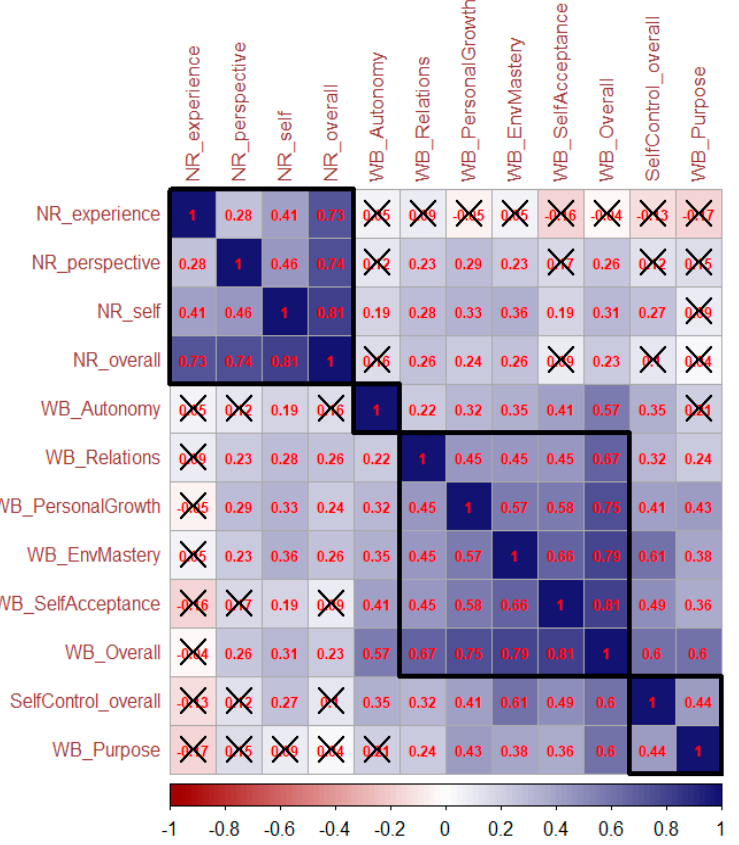
Figure 2. Correlation coefficients for Nature Relatedness and Psychological Well-being (women).